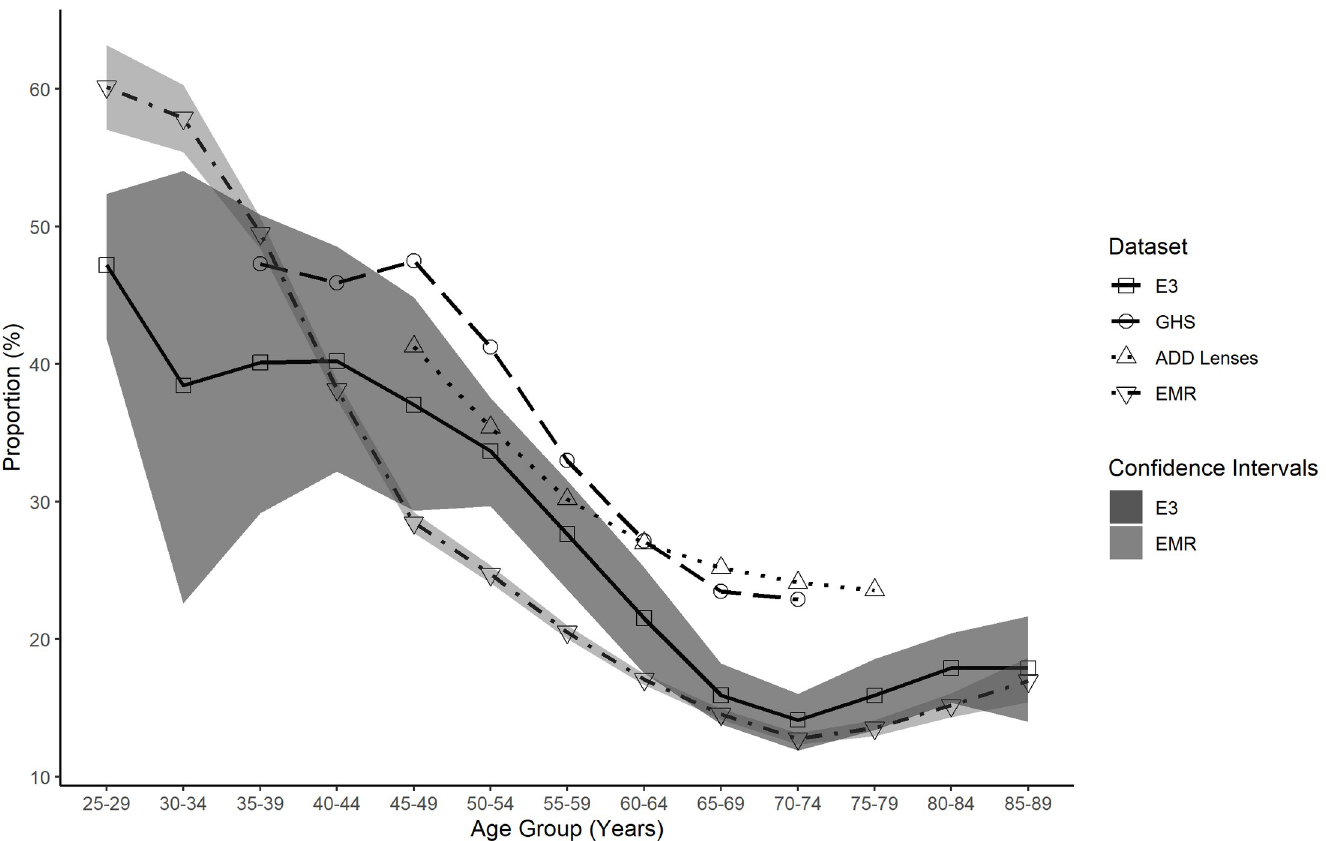
Fig 7. Total myopia proportion for all data sets as a function of age group. Total myopia proportion for EMR (inverted triangle), ADD Lenses (triangle), GHS (circle) and E3 (square) data as a function of age group. The E3 data confidence intervals (dark shaded area) are plotted to illustrate comparison with the other data sets. The EMR data confidence intervals (light shaded area) are plotted to show the overlap with the E3 data.